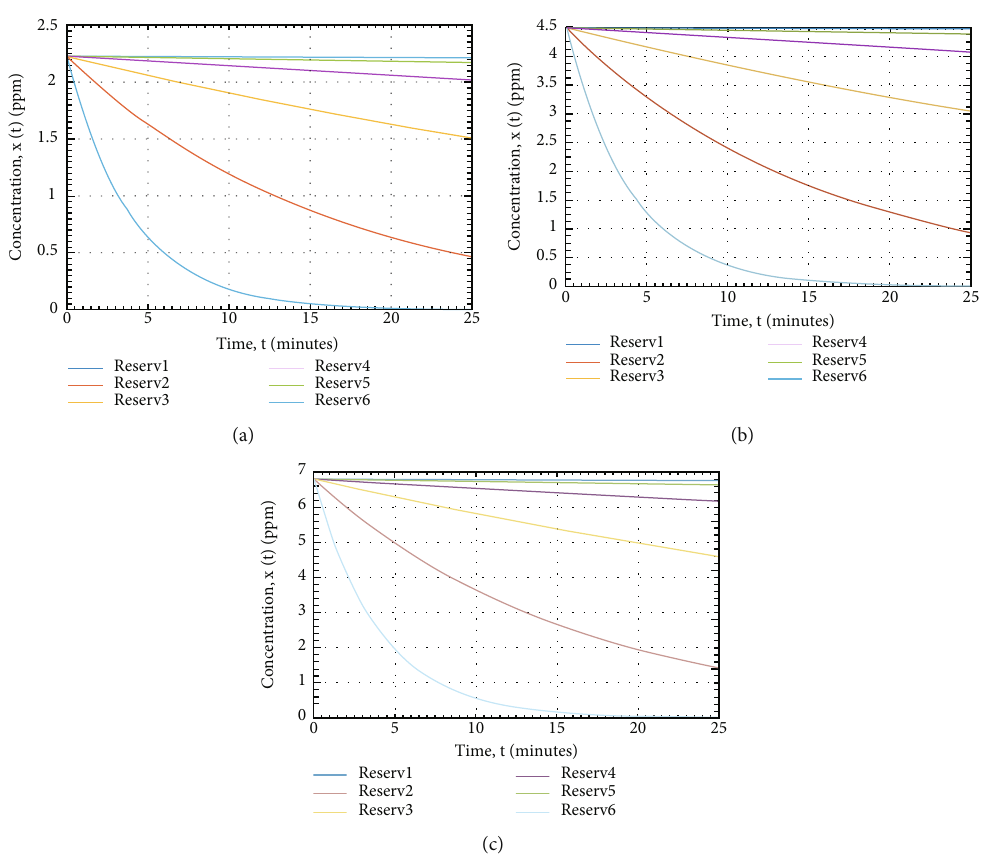
Figure 3: Time series trajectories for particle fl ow in reservoirs. Figures 3(a) – 3(c) show plots of Concentration x ð t Þ versus time t for SECTIONS A, B, and C, respectively, of river fl